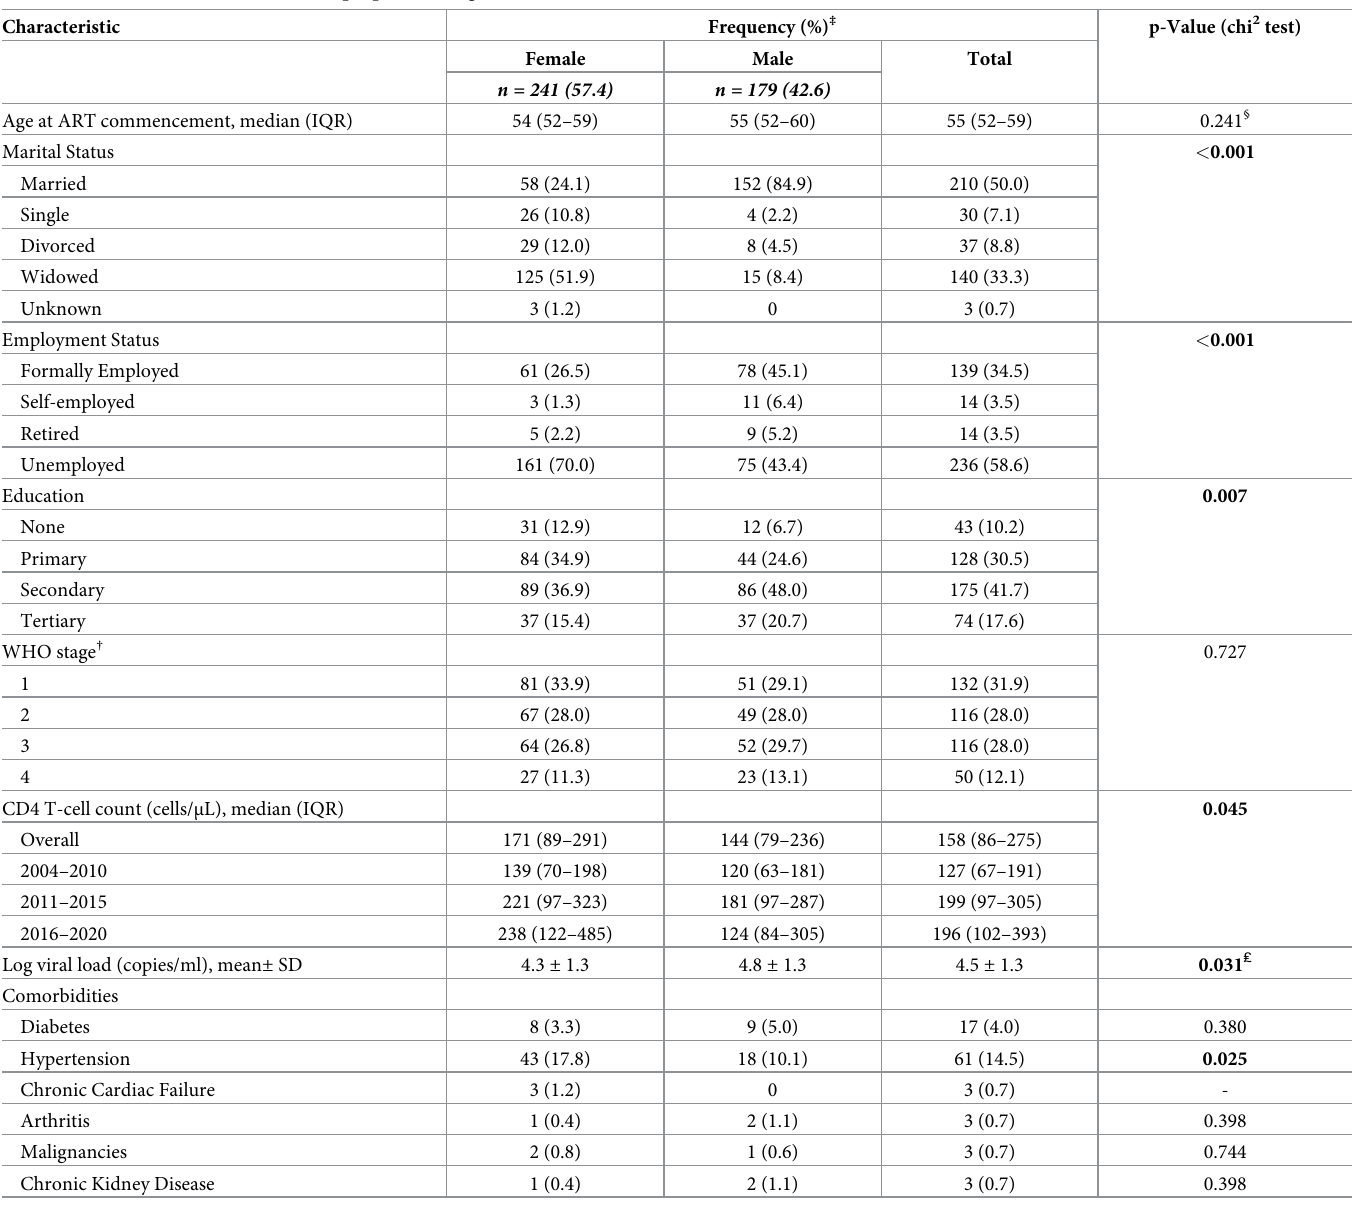
Table 1. Baseline characteristics of older people enrolling for ART at Newlands Clinic (N = 420).